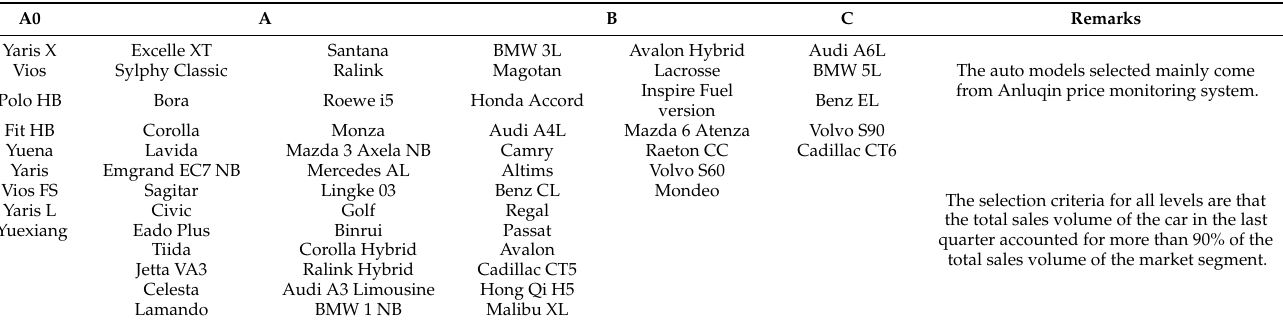
Table A2. Autos on sale at each